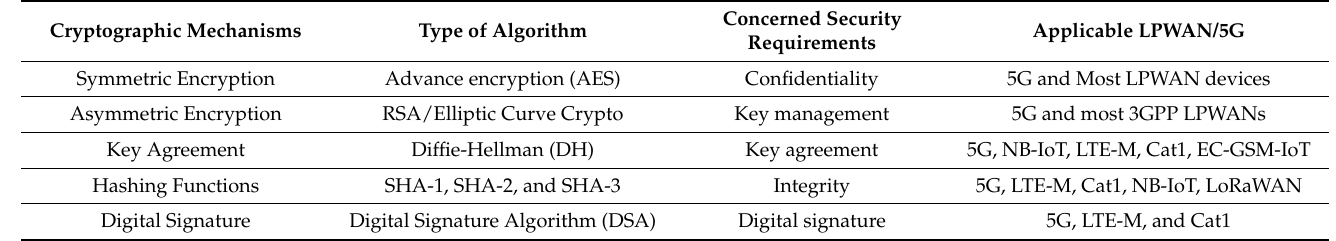
Figure 7. Proposed 5G Security by China IMT-2020 (5G) Promotion Group. Table 6. Cryptographic mechanisms and their encryption algorithms in 5G and LPWAN-IoT.